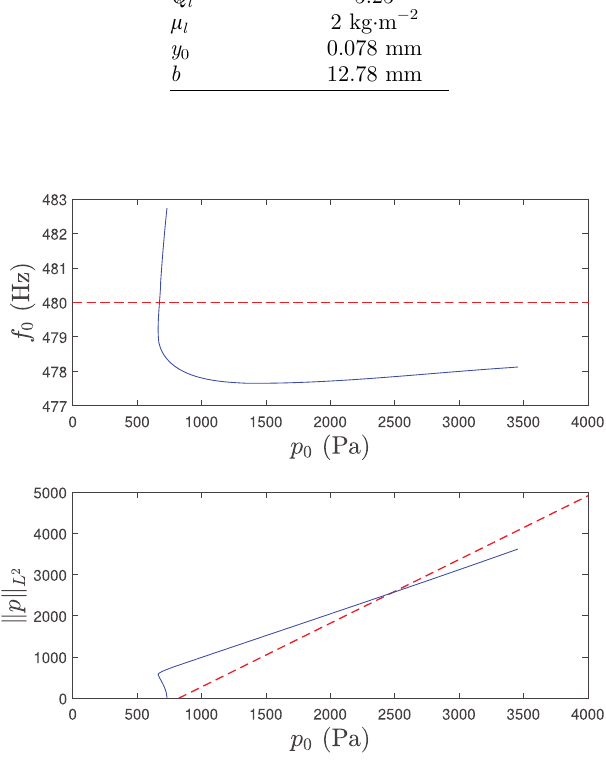
Figure 10. Initial bifurcation diagram (blue) and target diagram (dashed